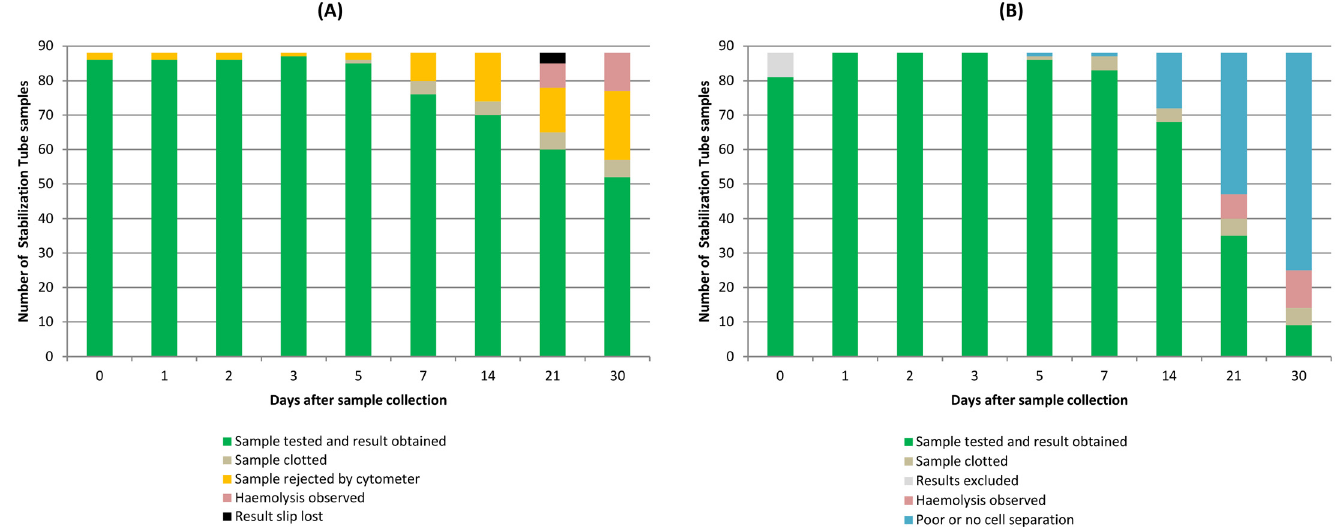
Fig 1. BD Vacutainer CD4 Stabilization Tube samples retained and results obtained over time. (A) Number of BD Vacutainer CD4 Stabilization Tube samples on BD FacsCount at days 0 – 30. (B) Number of BD Vacutainer CD4 Stabilization Tube samples on Partec Cyflow at days 0 –